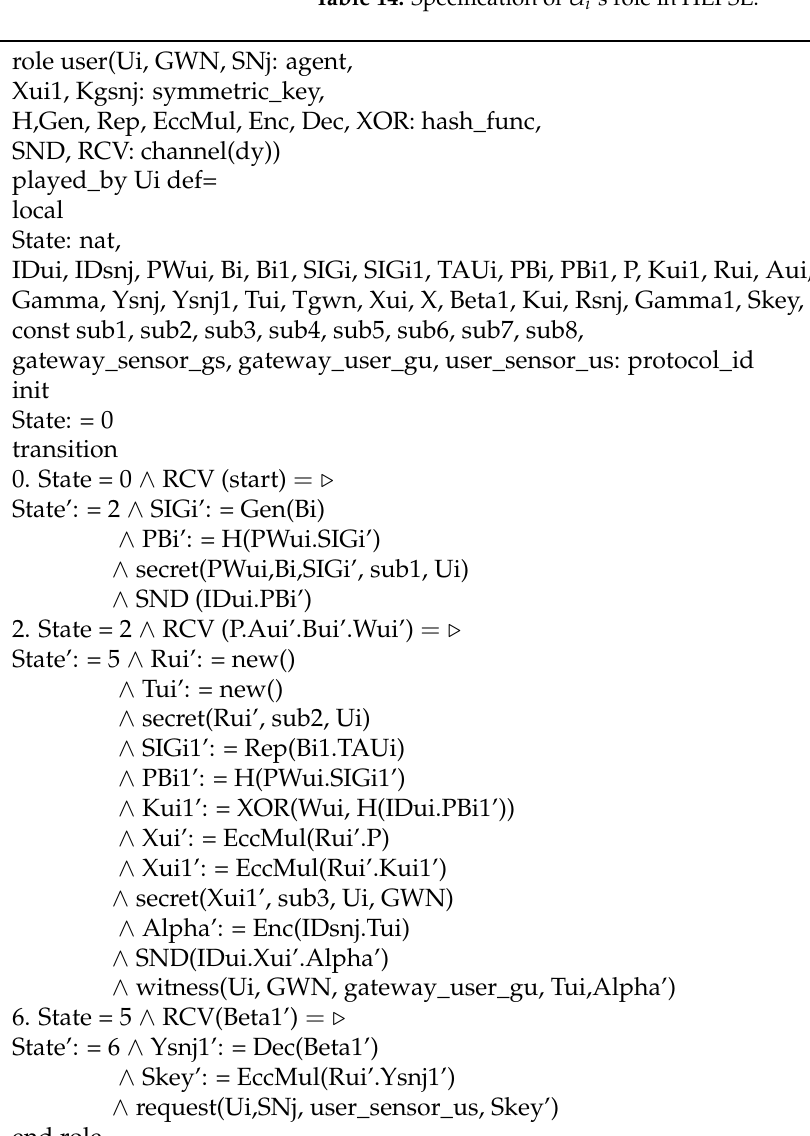
Table 14. Specification of U i ’s role in